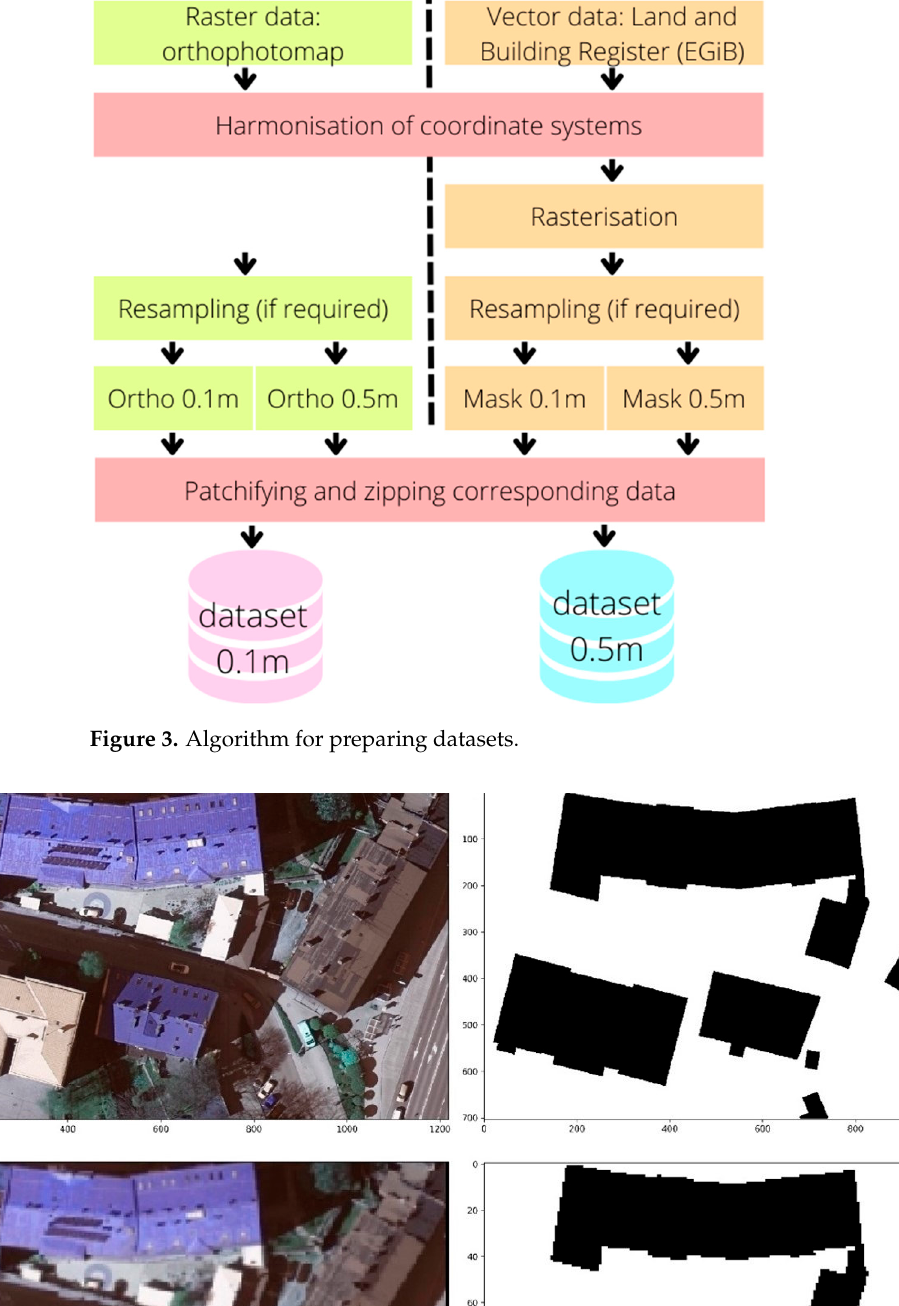
Figure 4. Comparison of datasets: ( a ) with 0.1 m pixel, ( b ) with 0.5 m pixel.